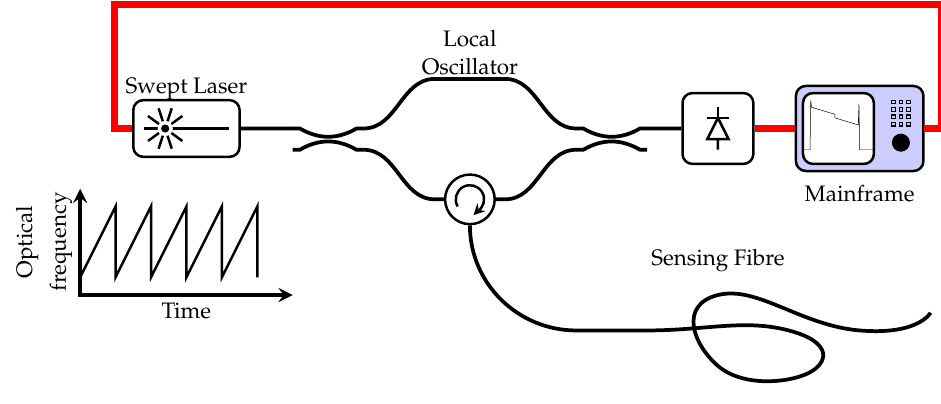
Figure 2. The principle of operation of the coherent OFDR